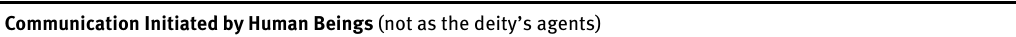
Table 2. Niphal ראה r-ʾ-h as Denoting the Advent of Communication